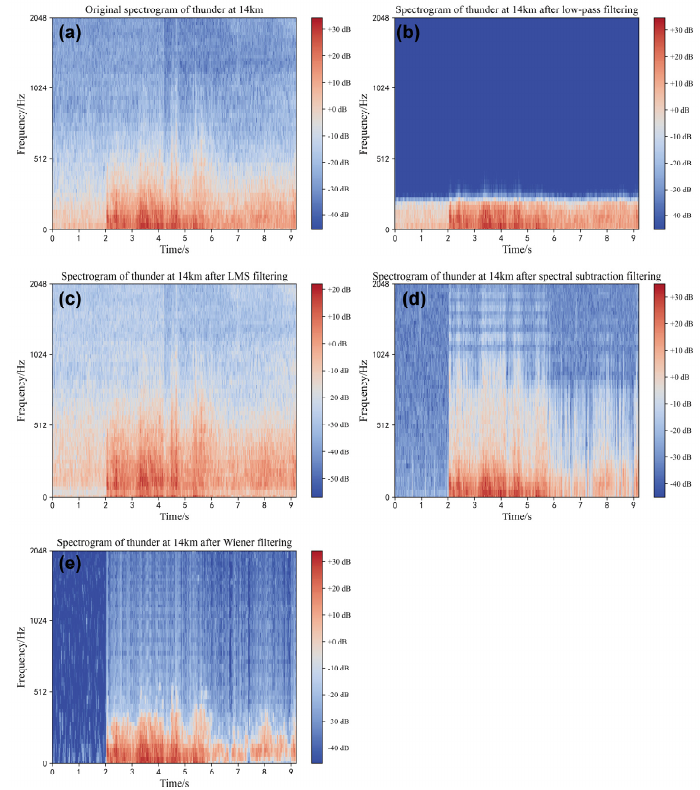
Figure 7. An acoustic spectrum of thunder that initiated at 14 km away from the observational site: ( a ) the original spectrogram; ( b ) the spectrogram after low-pass filtering; ( c ) the spectrogram after LMS filtering; ( d ) the spectrogram after spectral subtraction filtering; and ( e ) the spectrogram after Wiener filtering.